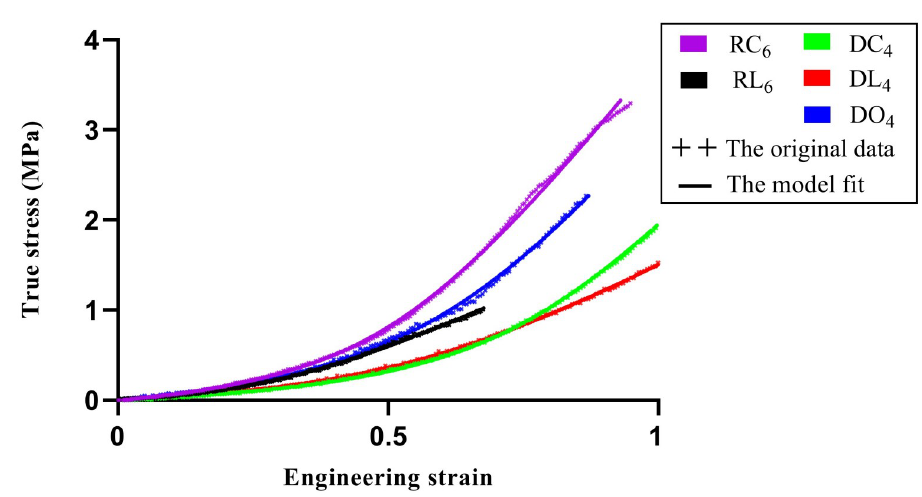
Fig 5. Representative data and model fitting.